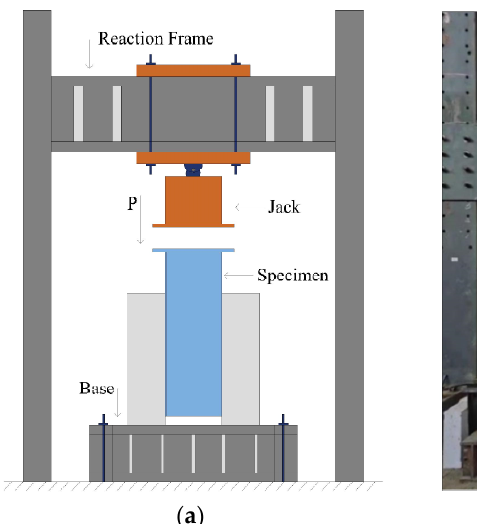
Figure 4. Arrangement of measurement points and displacement transducers: ( a ) static loading; ( b ) fatigue loading; ( c ) layout of measurement points: main view; ( d ) layout of measurement points: top view. 2.3.1. Static Loading Test Monotonic graded loading was adopted, starting with 10 kN as the load of each level, and the load for each level lasted for 10 min. When the load was increased to 50% of the ultimate load, each level of load was 5 kN, and when the load reached 80% of the ultimate load, the load level difference continued to decrease until the specimen was damaged. The measured data was automatically collected and recorded by the data acquisition instru- ment during the test. 2.3.2. Fatigue Loading Test For fatigue loading, the load varied sinusoidally, and the frequency of the fatigue testing machine was controlled at 4 Hz. The loading conditions of specimens F-1 to F-8 are shown in Table 3. Here, p u is the shear capacity of a single stud, which is obtained from the static loading test, and 25% and 50% of the shear capacity of a single stud are used as the minimum cyclic load p min and the maximum cyclic load p max , respectively; this is based on theoretical calculation. Δ P is the range of the cyclic load. Specimens F-1 to F-7 were completely unloaded after a certain number of fatigue loading cycles, and then they were loaded to failure by static loading. However, the specimen F-8 was loaded to failure by fatigue loading.